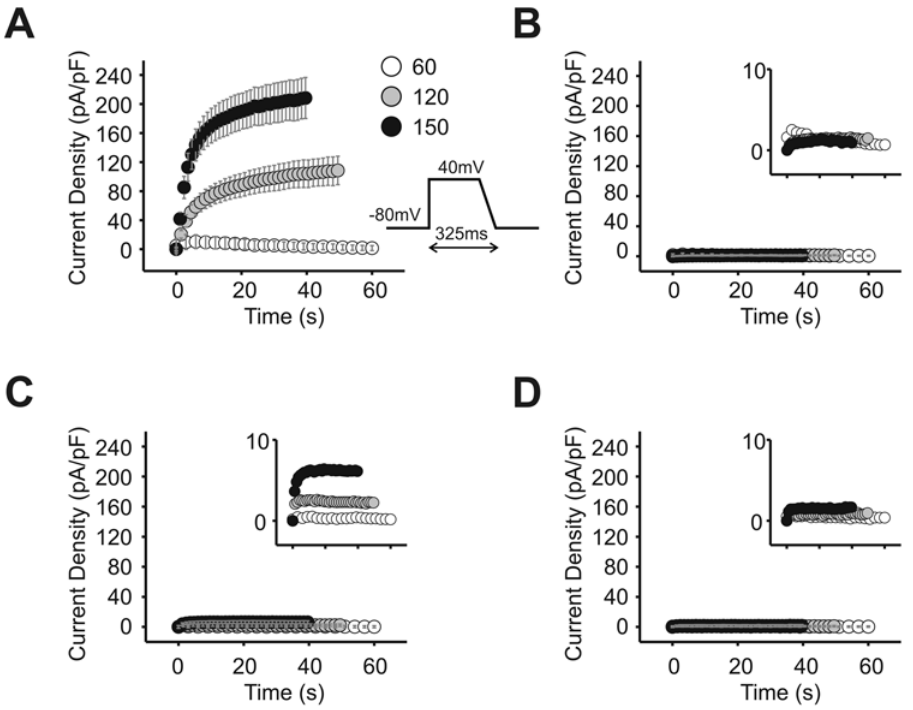
Figure 6. KCNE1-D76N and KCNE1- D 70 mutations result in defective rate-related accumulation of I Ks current. A series of 100 pulses mimicked action potential trains at three rates: 60, 120, or 150 per minute. On the voltage protocol, the grey stripe indicates the 10 ms over which the current measured was averaged and plotted on the graphs. The insets for B, C, and D show the Y-axis magnified and the points plotted without error bars. X- and Y-axes labels are the same as the main graph. A) Cells transfected with KCNQ1 (Q1) and wild-type KCNE1 (E1); depolarization length 325 ms. B) Cells transfected as in A, but depolarization length of voltage protocol adjusted as follows: 60 pulses/min-325 ms; 120 pulses/min-175 ms; 150 pulses/min-145 ms. C) Cells transfected with Q1 and E1-D76N; depolarization length 325 ms. D) Cells transfected with Q1 and E1- D 70; depolarization length 325 ms. n=6.